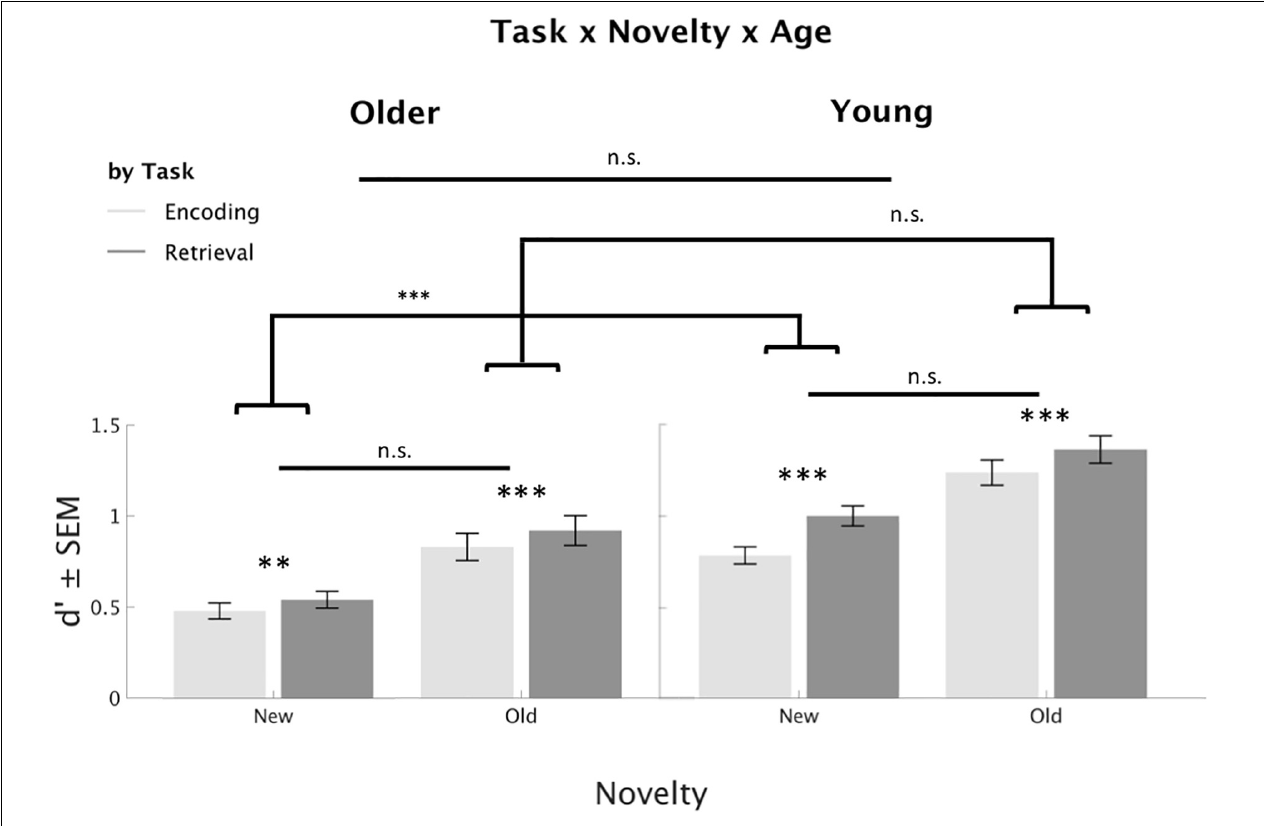
FIGURE 5 | Interaction of Task, stimulus Novelty, and Age group. The retrieval practice effect was significant for old and new stimuli, and there was no significant difference in strength between old and new stimuli. However, the difference between the RP for new stimuli seemed more pronounced in young adults in comparison to older participants. ∗∗∗ p < 0.001; ∗∗ p < 0.0056. TABLE 3 | Spearman correlation between TCI novelty seeking and RPEs, N = 141. TCI novelty seeking subscales Novelty seeking Exploratory excitability Impulsiveness Extravagance Disorderliness (includes all 4